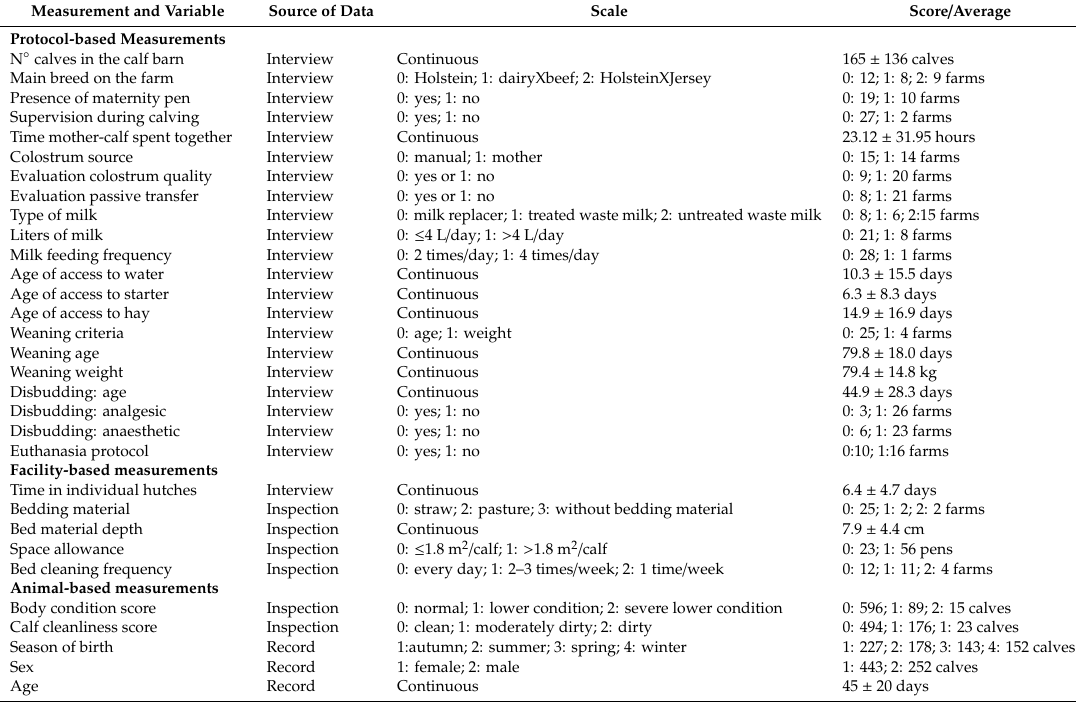
Table 2. Protocol-, facility-, and animal-based measurements gathered through interviews with calf managers, visual inspection by the researcher, and farm records during visits to 29 dairy farms using group pens in Los R í os region, Chile. Protocol-based Measurements N ◦ calves in the calf